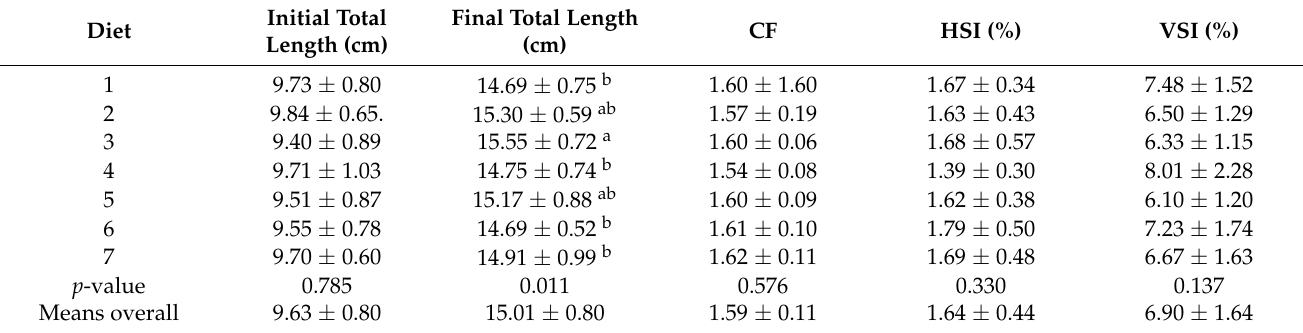
a,b—Different superscript letters indicate statistically different